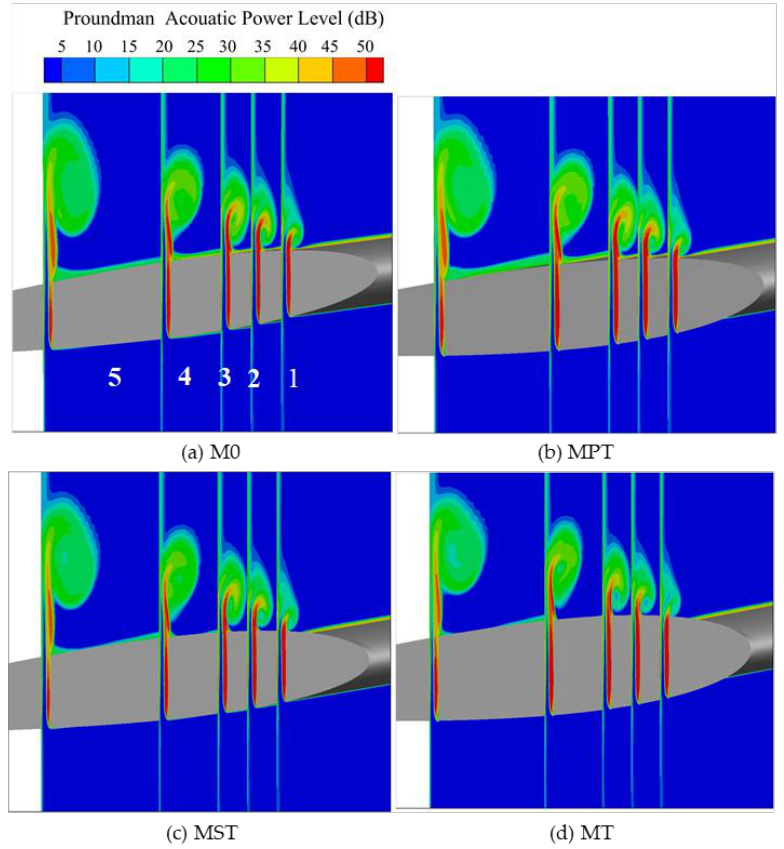
Figure 12. Proudman AP on five